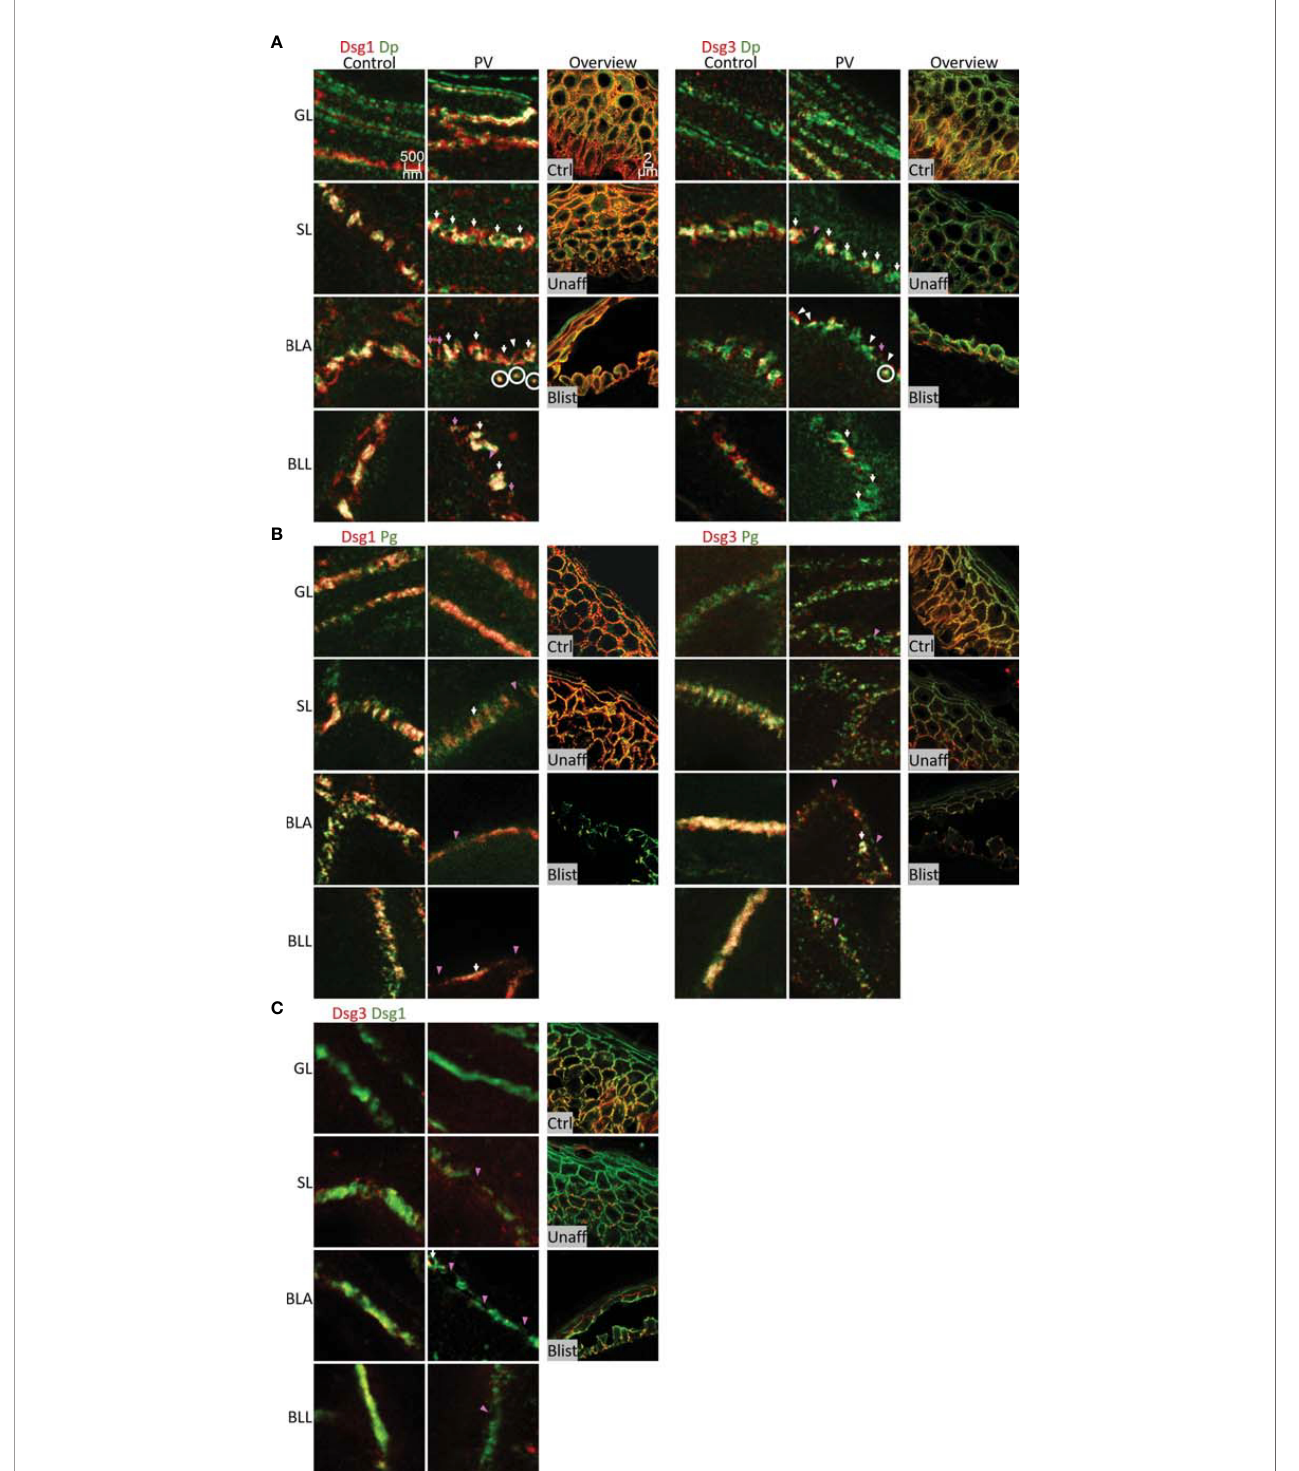
FIGURE 4 | STED microscopy images of single cell borders from control vs. PV patient skin, and confocal image for overview of control, unaffected PV skin and blister region of PV skin. Co-stained for: (A) Dsg1 or Dsg3 (red) and Dp (green). (B) Dsg1 or Dsg3 (red) and Pg (green). (C) Dsg3 (red) and Dsg1 (Green). Fragmented and depleted Dsg3 staining pink arrows, clustered Dsgs white arrows, Fragmented desmosomespink pointers, split desmosomes white pinters, cytoplasmic Dsg-Dp-units white circles. N (body donors)=5, n (cell